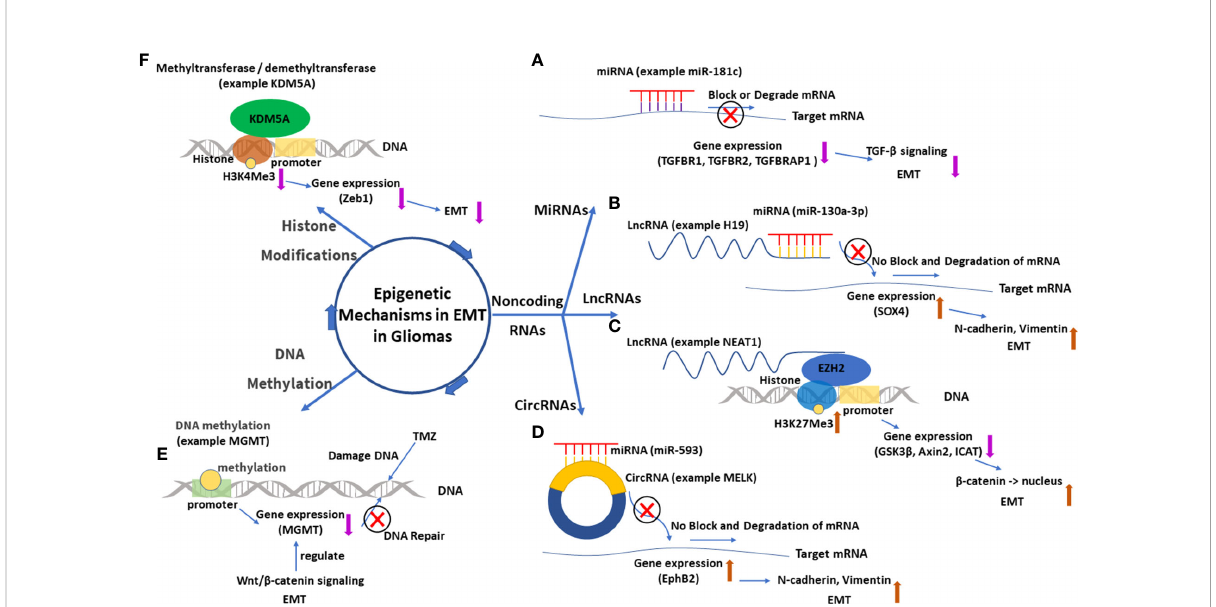
FIGURE 8 The main epigenetic mechanisms in EMT in gliomas. (A) MiRNA 181-c and its function of gene silence (TGFBR1, TGFBR2, and TGFBRAP1), which inhibits the TGF- b signal and suppresses EMT. (B) LncRNA H19 acts as a miRNA 130a-3p sponge, which enhances SOX4 expression and promotes EMT. (C) LncRNA NEAT1 downregulates expressions of GSK3 b , Axin2, and ICAT by recruiting EZH2, which catalyzes H3K27Me3. The downregulated GSK3 b and Axin2 then promote the nuclear transport of b -catenin, which enhances EMT. (D) CircRNA MELK acts as a miRNA 593 sponge, which enhances EphB2 expression and promotes EMT. (E) Methylation of the promoter of the MGMT gene downregulates MGMT expression and enhances the effect of TMZ. EMT can regulate MGMT expression through the Wnt/ b -catenin signal pathway. (F) Histone demethyltransferase KDM5A decreases the content of H3K4Me3, which downregulates Zeb1 and suppresses EMT. EMT, epithelial – mesenchymal transition; lncRNA, long non-coding RNA; circRNA, circular RNA; miRNA,